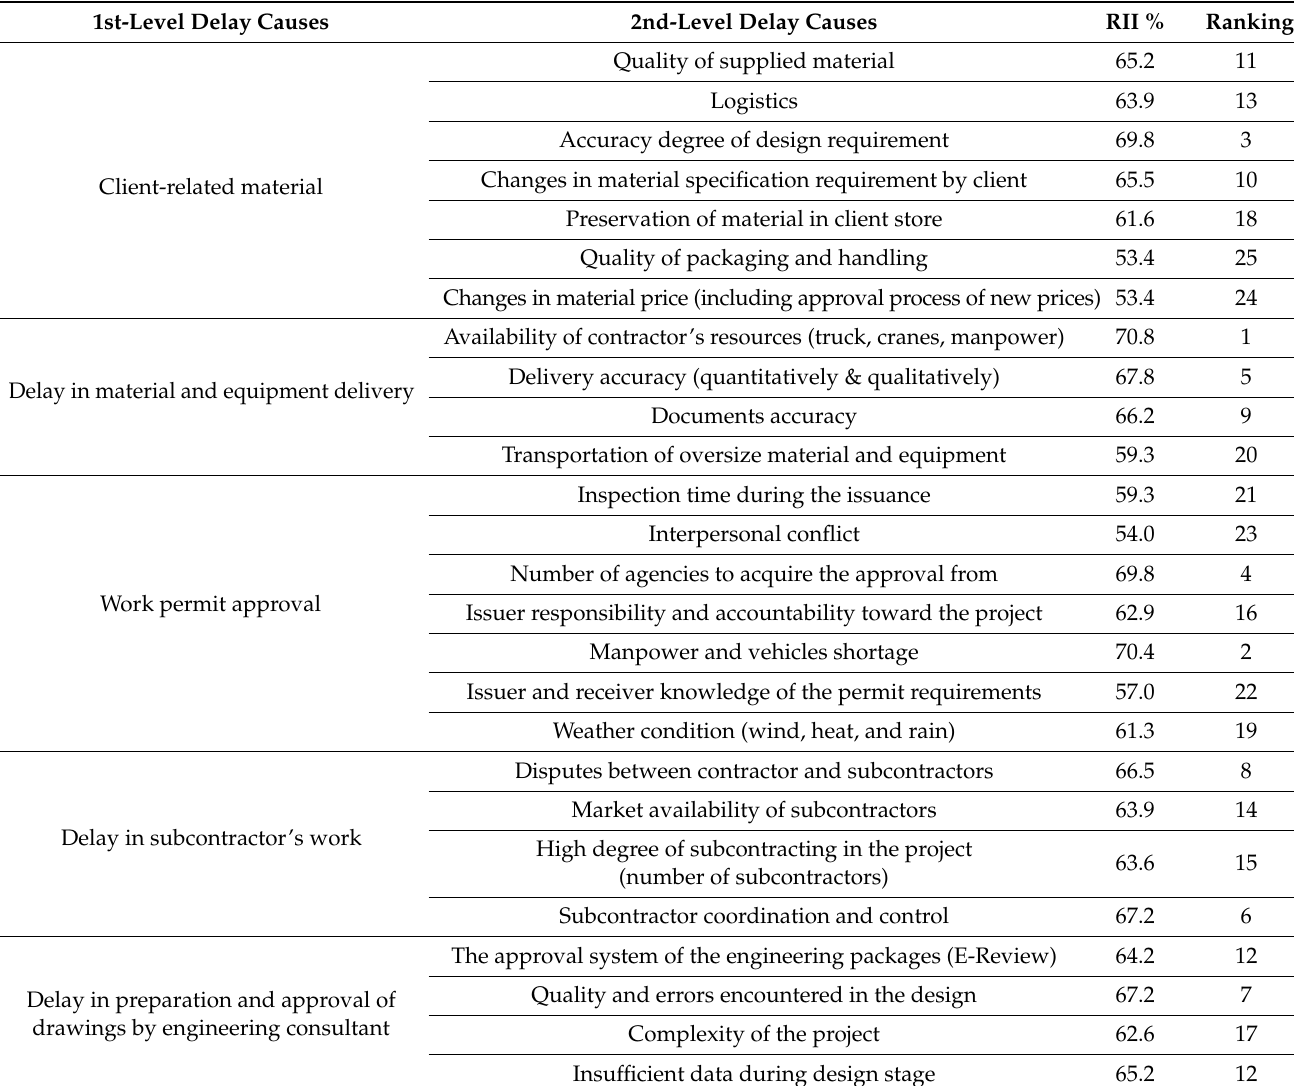
Table 9. Weighted ranking of root causes of delay in oil and gas project in